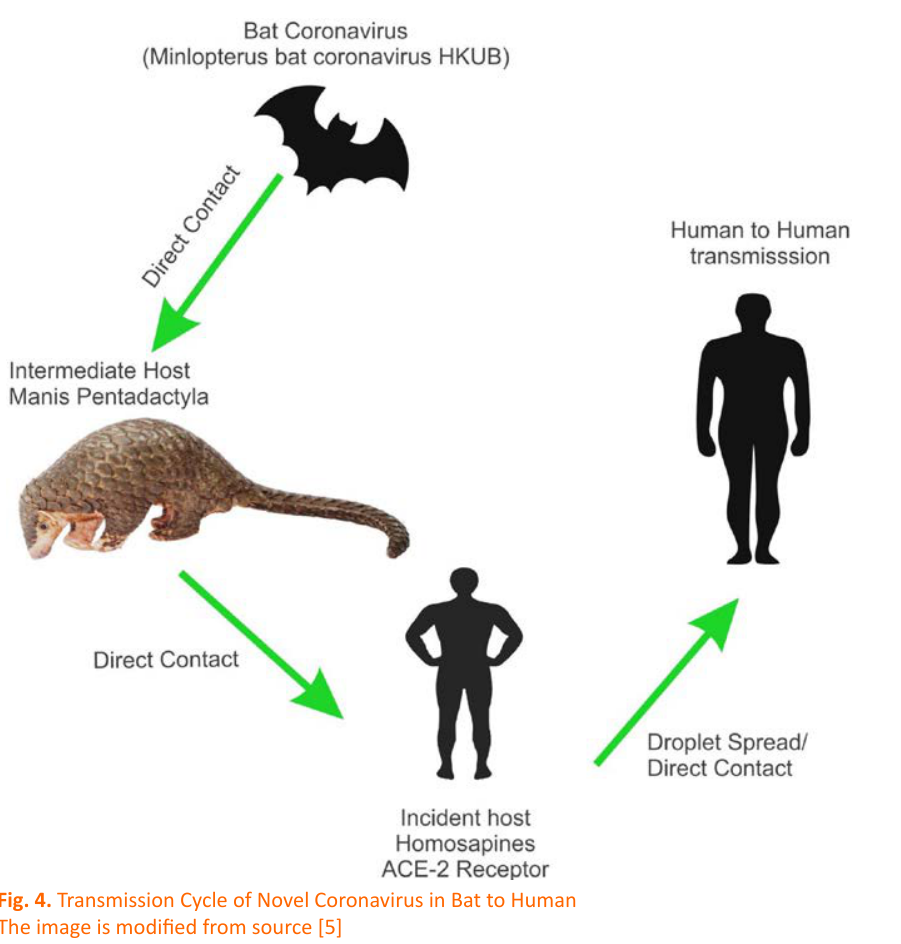
Fig. 4. Transmission Cycle of Novel Coronavirus in Bat to Human The image is modified from source